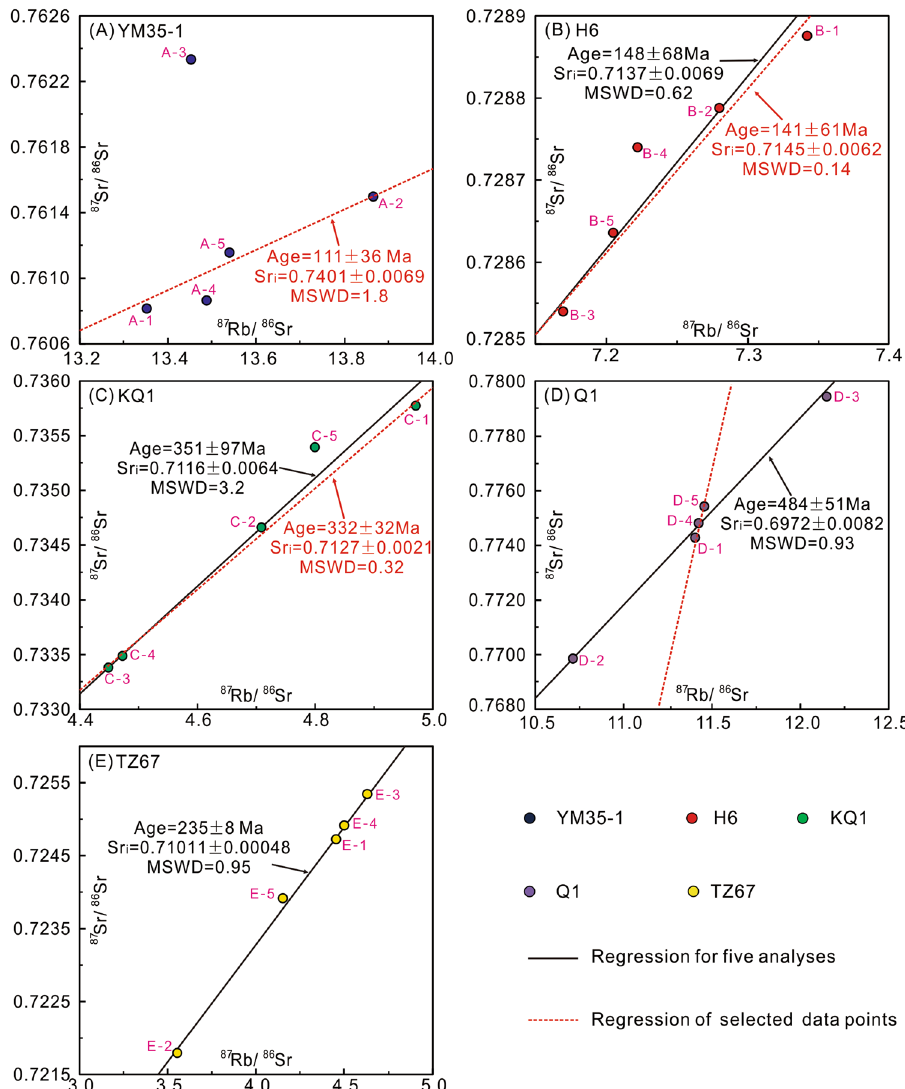
Figure 6. Scatter plots of 87 Rb/ 86 Sr vs 87 Sr/ 86 Sr ratios. The black line in each diagram is the isochron regressed from data of all subsamples. The red dash line is the isochron regressed through selected data. ( A ) YM35-1. The red dashed line is regressed without subsample A-3; ( B ) H6. The red dashed line is regressed without subsample B-4; ( C ) KQ1. The red dashed line is regressed without subsample C-5; ( D ) Q1. The red dashed line is regressed without subsamples D-2 and D-3; ( E )